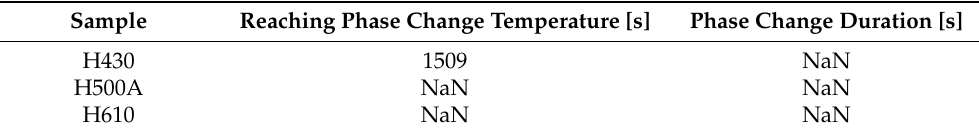
Figure 11. TESS charging under WLTC cycle condition. Table 4. TESS charging time for varying PCM samples (WLTC).